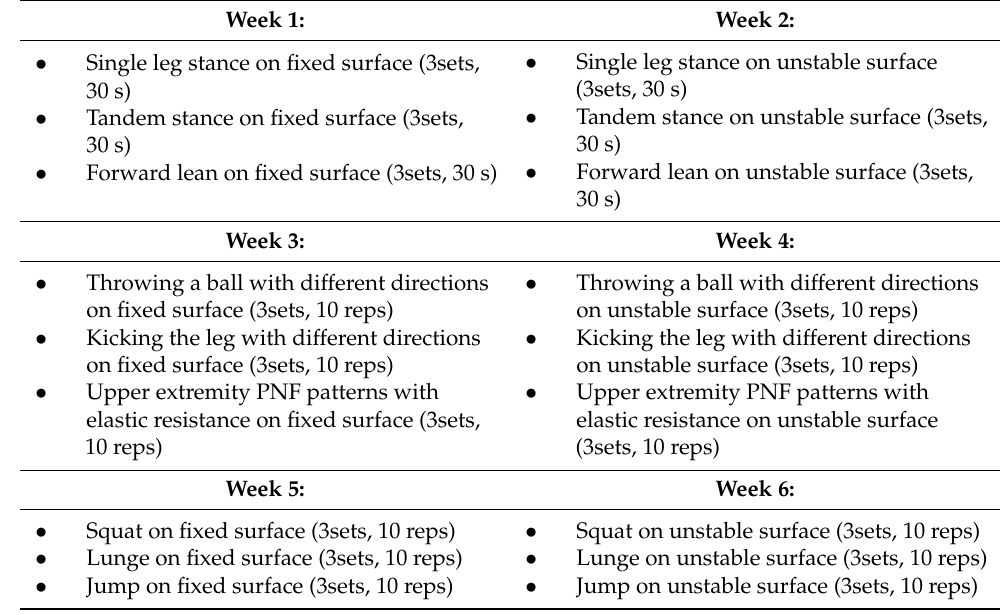
Figure 1. Short-foot exercise. Table 1. Sensorimotor training